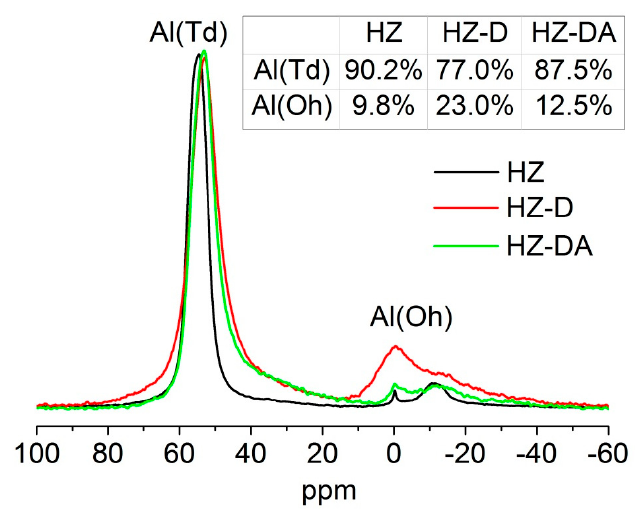
Figure 4. 27 Al MAS NMR spectra of tested catalysts.